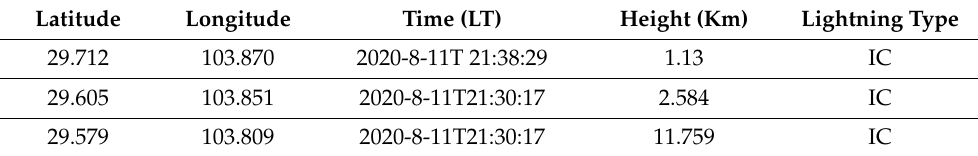
Table 2. VLF data records of two lightning cases.